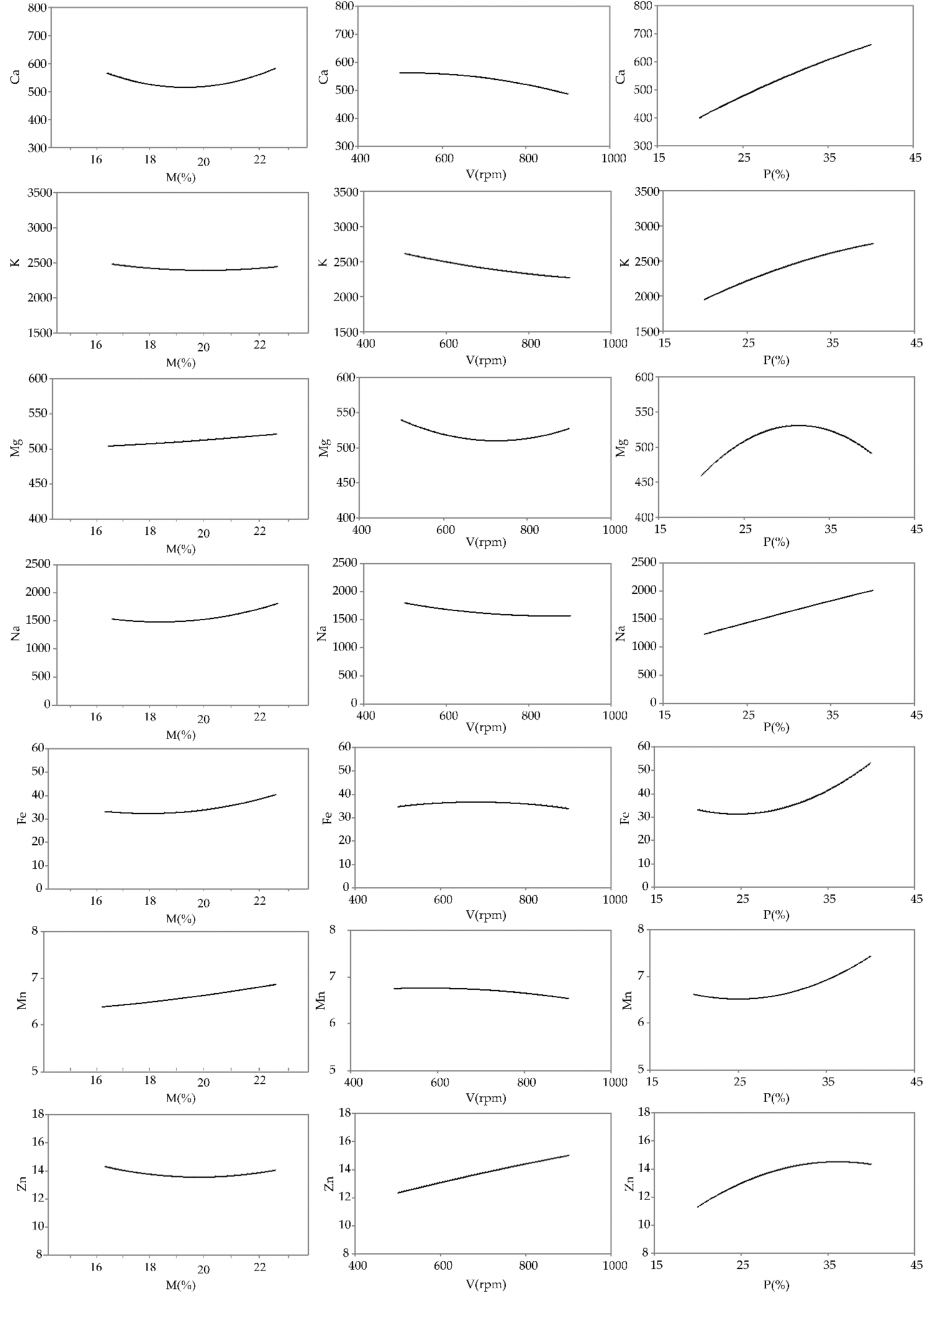
Figure 4. Influence of extrusion conditions (M—moisture content; V—screw speed; P—chicory root content) on mineral